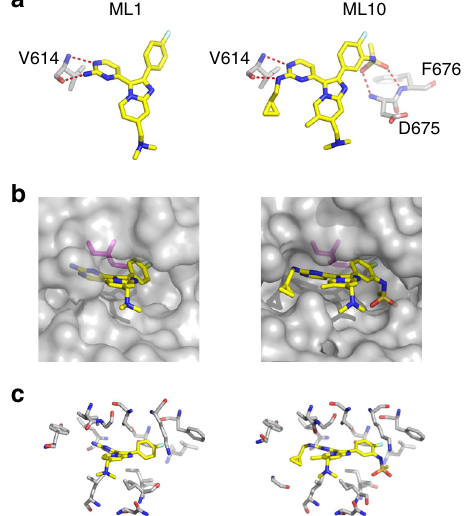
Fig. 4 Side-by-side comparison with key features in the PvPKG/ML1 and PvPKG/ML10 co-structures. a Hydrogen bonds provide key interactions: At the hinge of the kinase domain, V614 forms hydrogen bonds with the amino-pyrimidine group of both ML1 ( left ) and ML10 ( right ). In addition, ML10 extends a sulfonamide moiety to form hydrogen bonds with D675 and F676, resulting in signi fi cantly greater inhibitory potency than ML1. b Gatekeeper confers speci fi city: Both ML1 ( left ) and ML10 ( right ) extend a fl uorophenyl group to occupy a hydrophobic pocket adjacent to T611 ( magenta ). This explains in part the speci fi city of the inhibitors as a residue with a longer side-chain may potentially clash with this functional group.